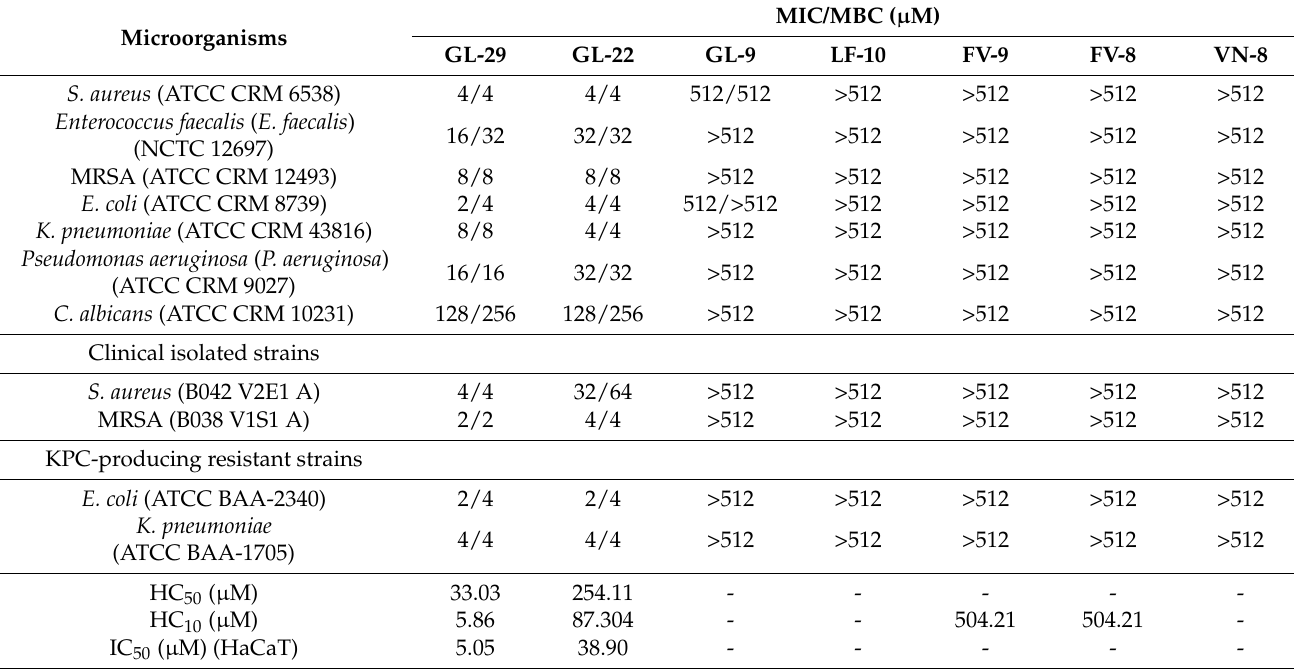
Table 2. The MICs and MBCs of GL-29 and its short analogues.